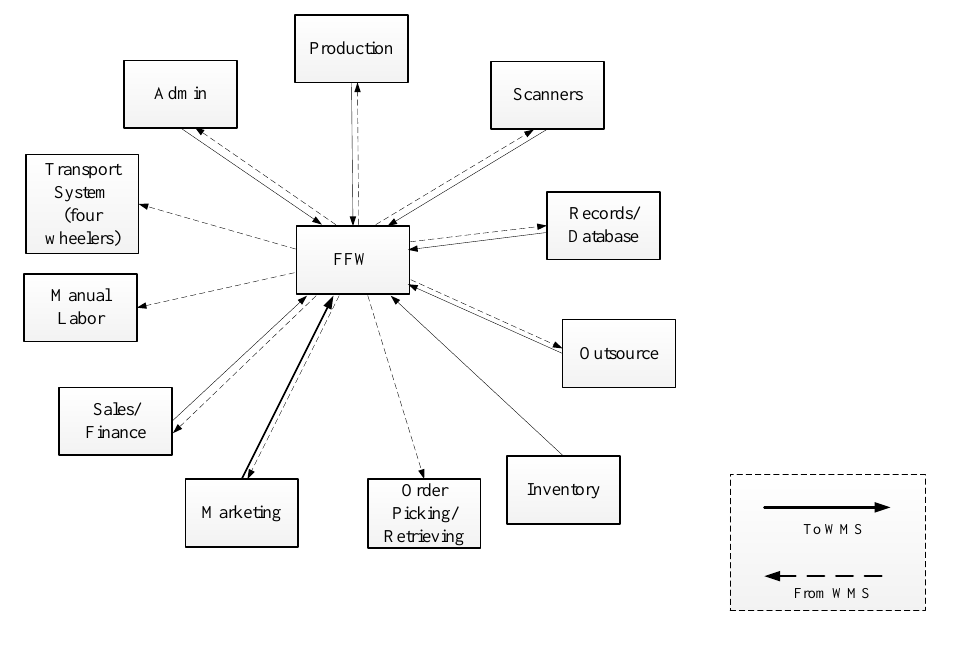
Figure 7. Context diagram (for the case